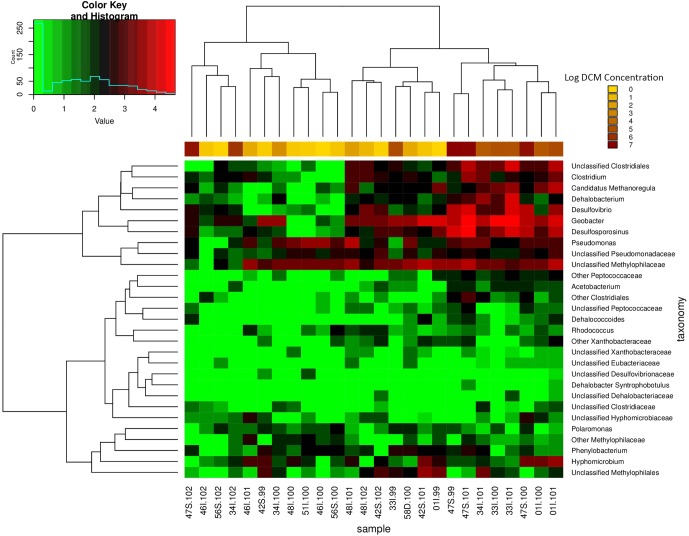
Relative abundance heatmap of potential DCM-degrading biomarker taxa. This heatmap displays the abundance of 29 taxa previously associated with growth on DCM or similar contaminants within each groundwater sample (n = 26). Taxa of high abundances are highlighted in red, whereas taxa of low abundance are highlighted in green. Samples with higher DCM concentrations possess the highest abundances of biomarker taxa of interest, with as much as a four order of magnitude difference in abundance in comparison to samples of lower DCM concentration. As a result, samples of high DCM concentration appear to cluster together on the right side of the plot. Unclassified Clostridiales, Clostridium, Candidatus Methanoregula, Dehalobacterium, Desulfovibrio, Desulfosporosinus, Pseudomonas, and Unclassified Methylophilaceae are present in the highest abundance within the high DCM concentration samples. The data suggest that the presence and abundance of the potential DCM degrading taxa of interest may be driving the observed shift in microbial community structure with increased DCM concentration. A majority of the anaerobic DCM degraders are observed in higher within the samples with higher levels of contamination, but do not thrive within samples with lower contamination. Clustering of samples further supports the finding of niche-specific DCM degrading assemblages within samples of similar DCM concentrations.